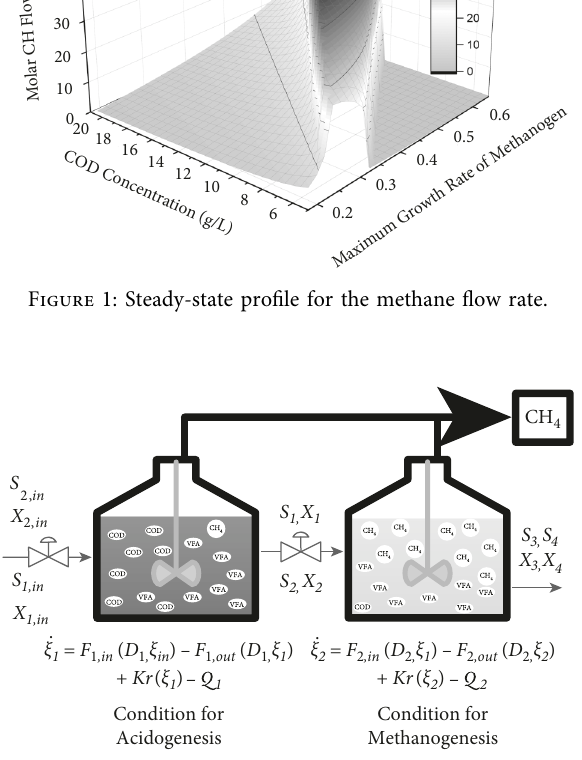
Figure 2: Schematic of a two-stage anaerobic digestion